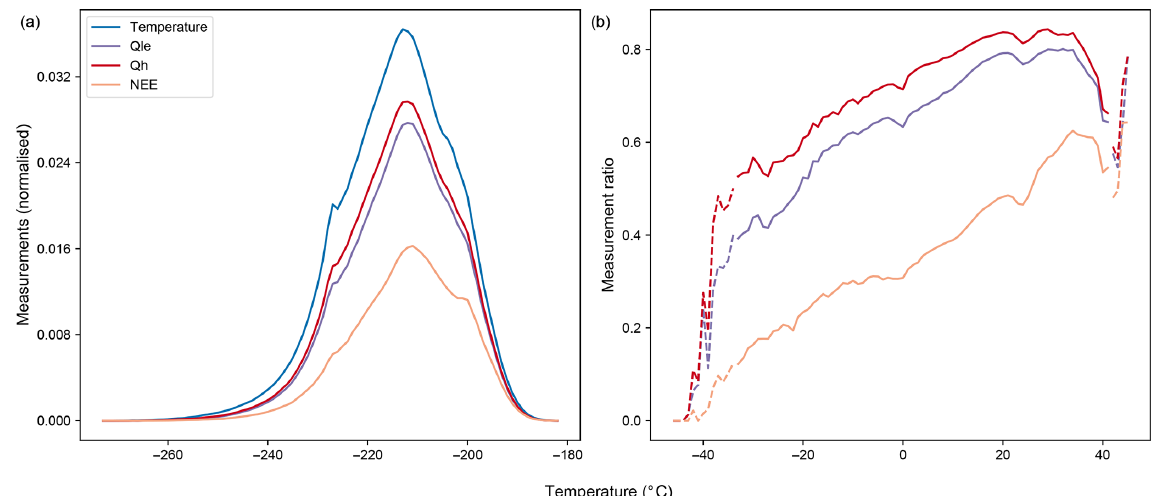
Figure 1. Availability of temperature, Q le , Q h and NEE measurements in each 1 ◦ C temperature bin. Panel (a) shows the normalised number of measurements of temperature, Q le , Q h and NEE. Panel (b) shows the ratio of Q le , Q h and NEE measurements relative to temperature measurements. NB: in panel (b) the dashed lines indicate measurement ratios where the number of samples was less than 1000 (please see the text for further